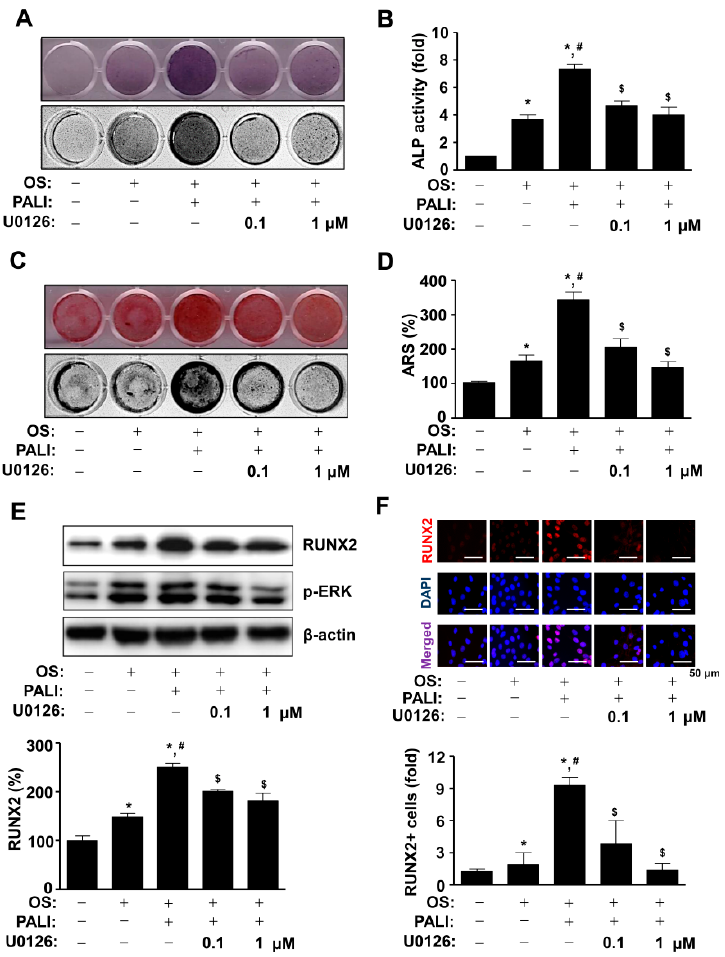
Figure 5. Effects of paeonolide (PALI)-induced ERK1/2 signals on osteoblast differentiation. ( A , B ) After pre-osteoblasts were treated with PALI (10 μ M) in the presence or absence of U0126 (1 and 10 μ M) during osteogenic supplement medium (OS)-induced osteoblast differentiation, alkaline phosphatase (ALP) staining was analyzed using a scanner ( upper ) and a colorimetric detector ( bottom ) ( A ), and the enzymatic activity of (ALP) was measured at 405 nm using a spectrophotometer and is expressed as a bar graph. ( C , D ) Alizarin red S (ARS) staining was analyzed using a scanner (upper) and a colorimetric detector (bottom) ( C ), and the intensity of mineralized nodule formation was quantified and is expressed as a bar graph ( D ). ( E , F ) Equal amounts of lysates were analyzed using Western blot analysis and detected with antibodies against RUNX2 and phospho-ERK (p-ERK). β -Actin was used as a loading control ( E ). The fixed cells were analyzed using immunofluorescence analysis and immunostained with antibody against RUNX2 (red). DAPI (blue) was used as a nuclear marker. The bottom panels show the merged images (purple) of the first and second panels. RUNX2+ cells (fold) were expressed as a bar graph. Scale bar: 50 µ m. Data are representative of the results